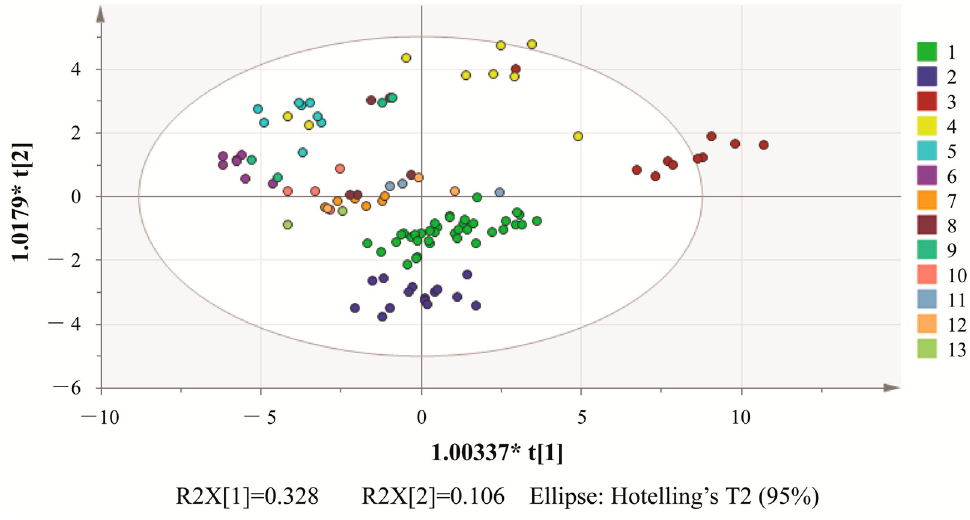
Figure 3. The scores plot obtained by PCA of the 113 samples, LFS (1), BYS (2), WNQ (3), JY (4), XF (5), JK (6), BH (7), GF (8), JM (9), YH (10), QZ (11), LS (12) and QT (13).